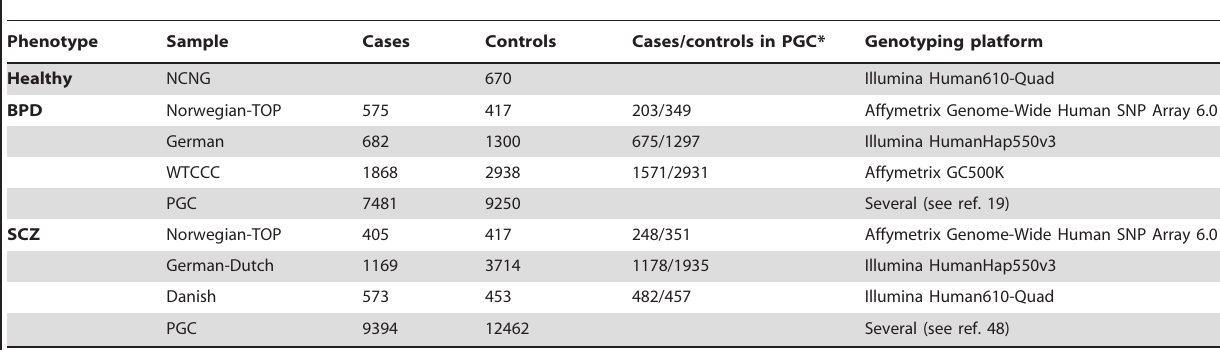
Table 1. Description of the